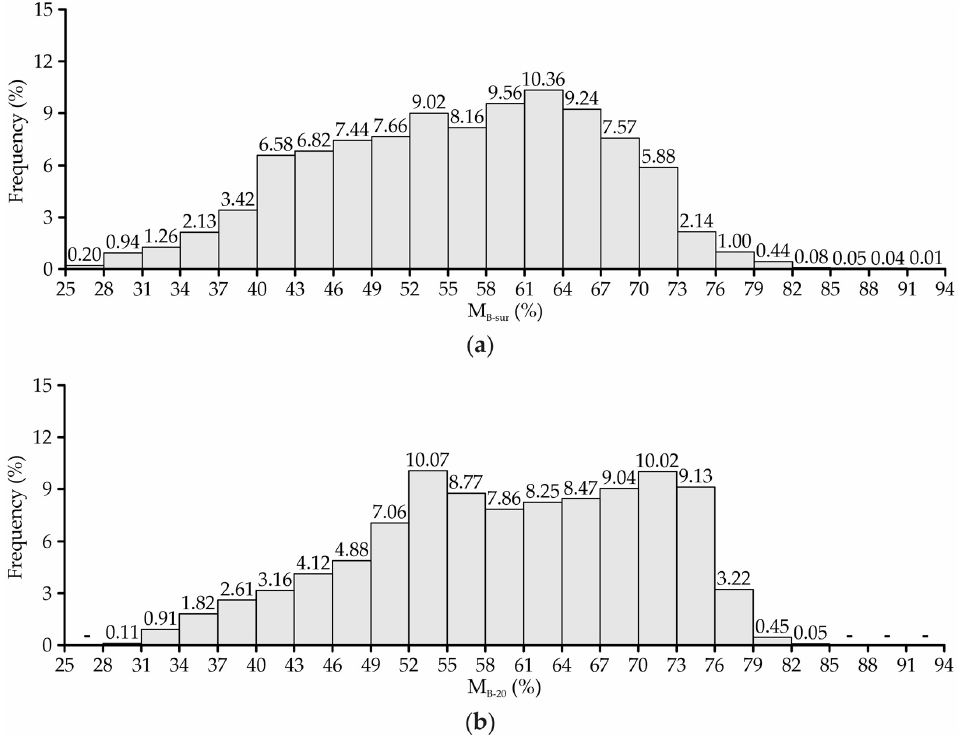
Figure 6. Frequency distribution of bedding moisture at the surface—M B-sur ( a ) and at a depth of 0.2 m—M B-20 ( b ).